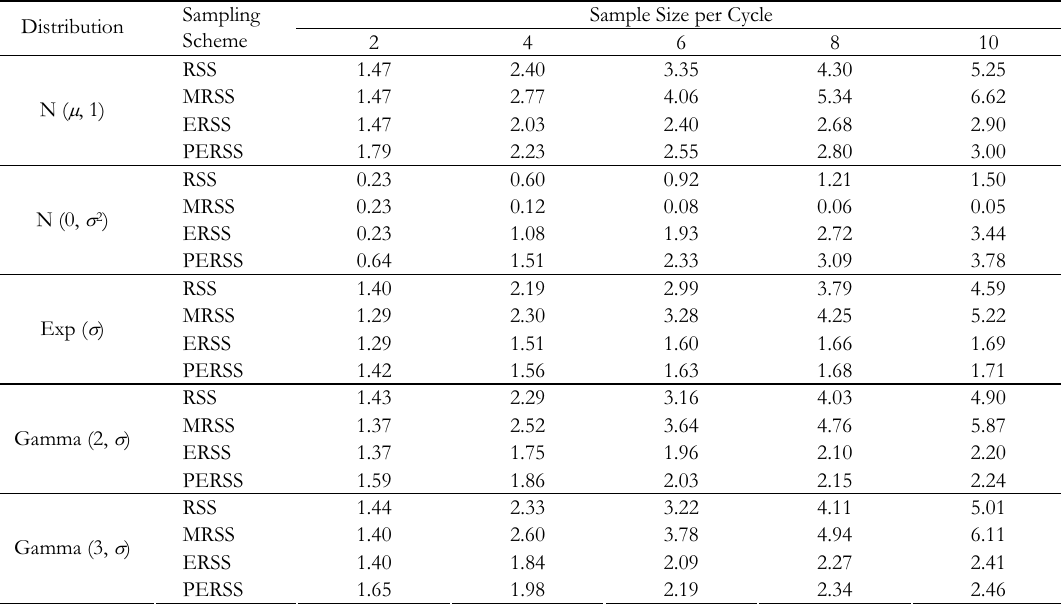
The relative precision of the RSS, MRSS and ERSS linear unbiased estimators and that for the corresponding PERSS for even set sizes per cycle